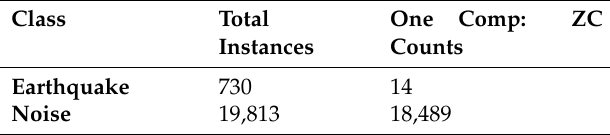
Table 2. ZC count at only one